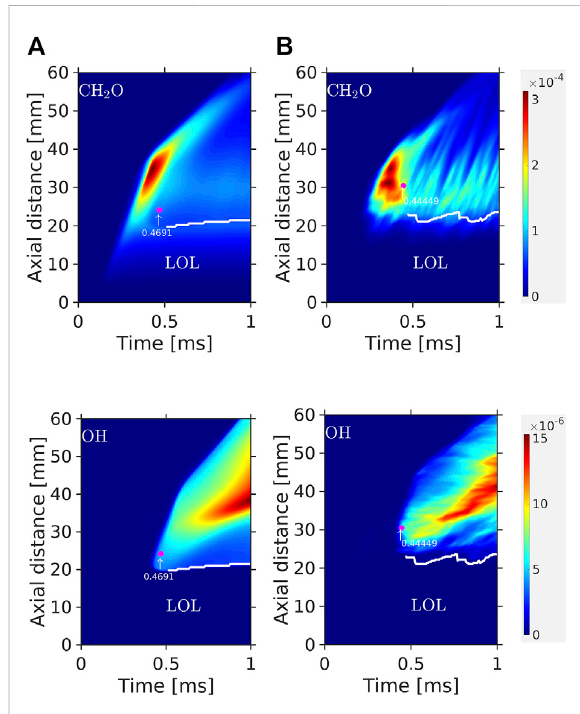
FIGURE 8 I xt -plots for Spray D in the RANS (A) and LES (B) frameworks. The purple dot represents the IDT.